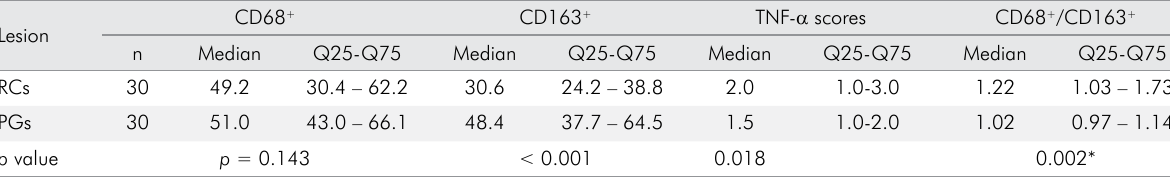
Table 5. Percentages of CD68 + , CD163 + , and CD68 + /CD163 + ratio in RCs and PGs. CD68 + CD163 + TNF- α scores CD68 + /CD163 + Lesion n